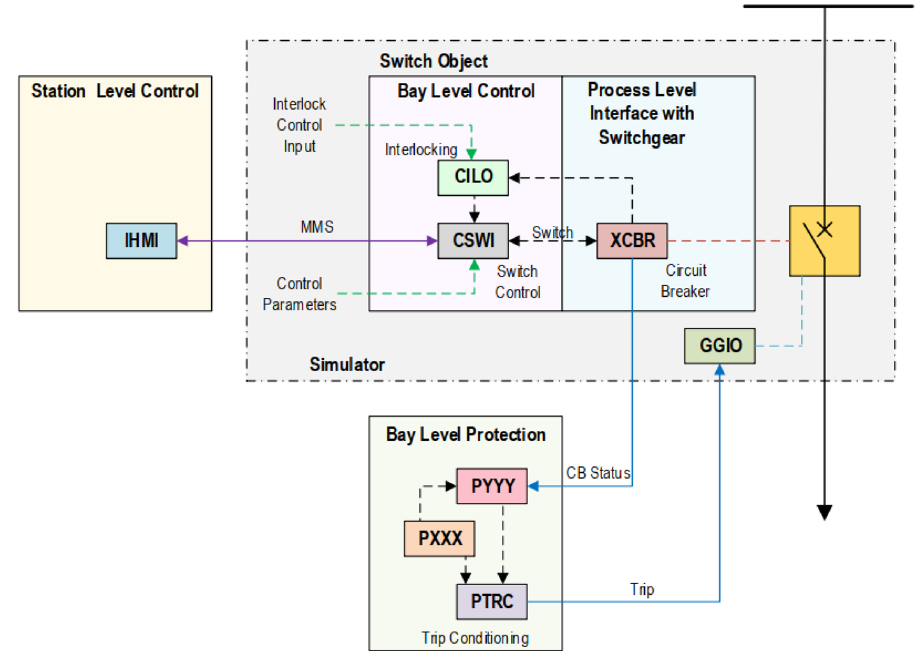
Figure 1. Circuit breaker control based on switch object 22 .